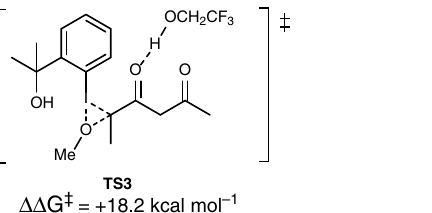
Fig. 6 Proposed intramolecular reaction mechanism. a DFT calculations for the umpolung reaction of γ -keto allylic alcohols. b TS for the α -methoxylation of γ -keto allylic